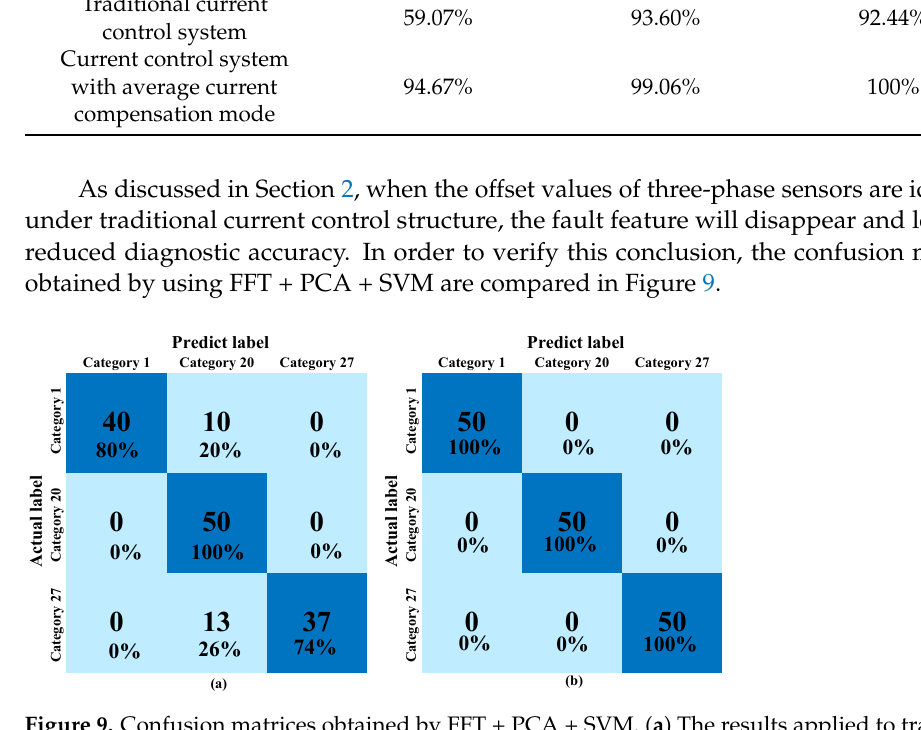
Table 3. Comparison of diagnostic accuracy.